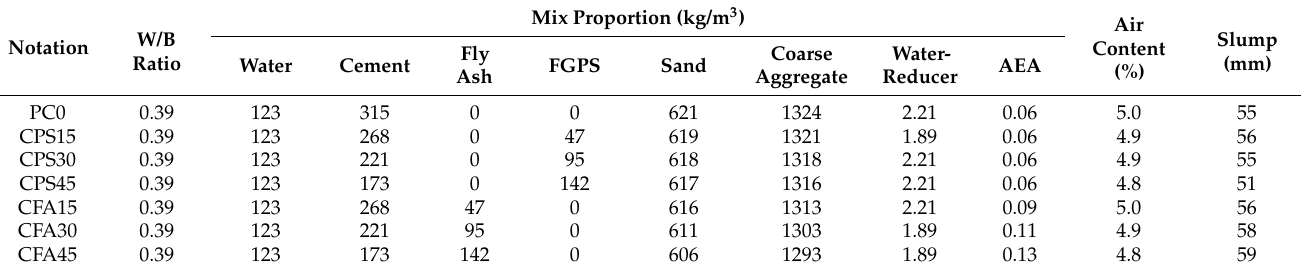
Table 2. Mix proportion and notation of hydraulic concrete.